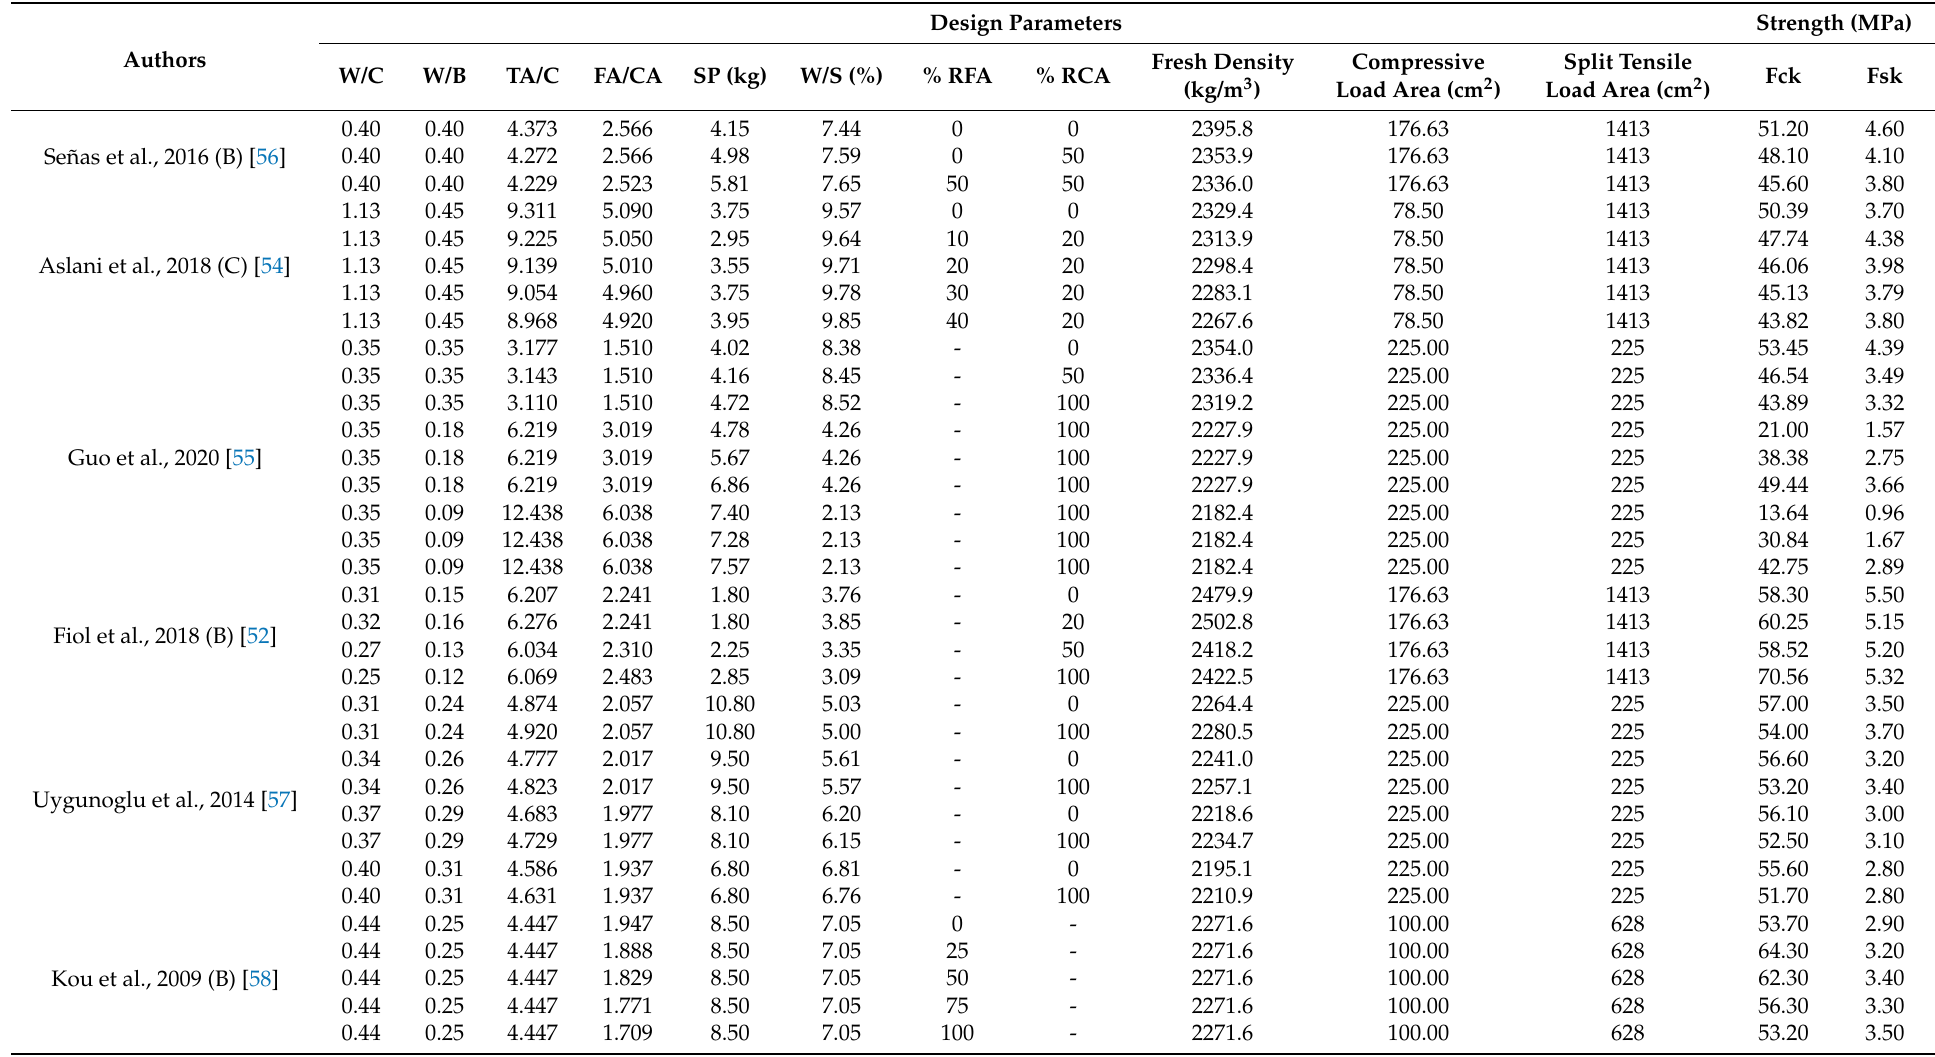
Table 3. Family III (Compressive strength range–50 MPa to 60 MPa) design parameters according to